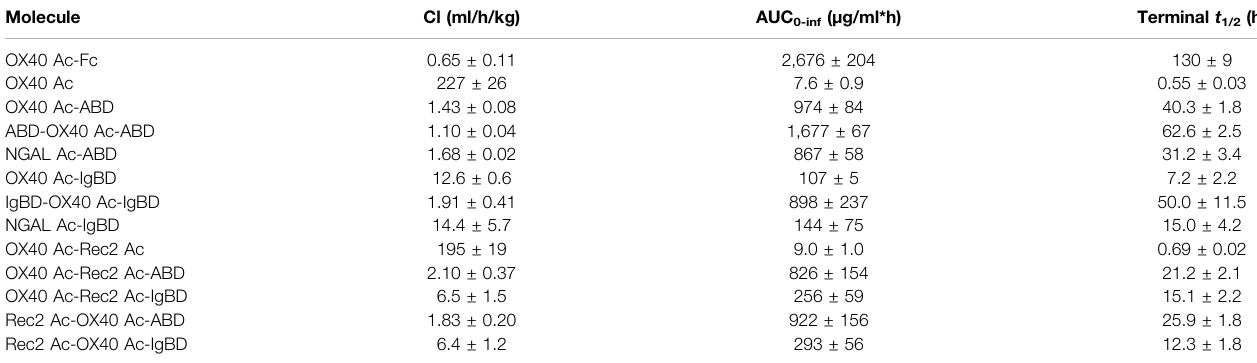
TABLE 3 | Pharmacokinetic parameters of Anticalin proteins in CD-1 wild-type mice (n (cid:2) 3, mean ± S.D.). Molecule